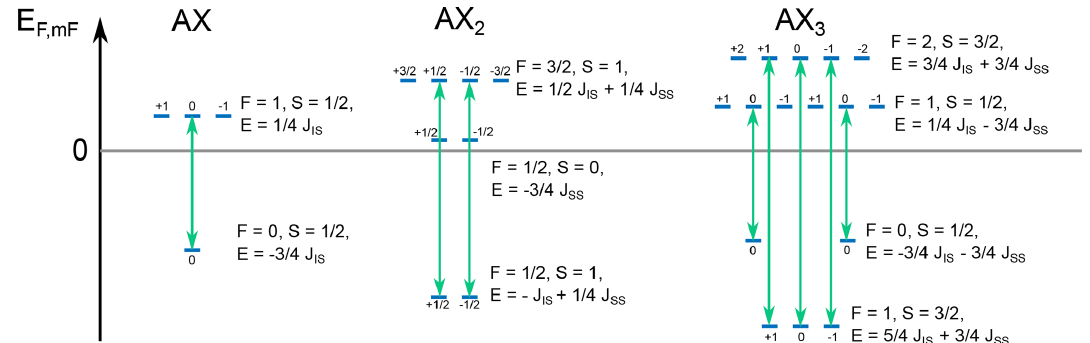
Figure 8. Energy levels for XA, XA 2 , and XA 3 spin systems calculated according to Eq. (54). The numbers above the energy levels represent the z projection of the angular momentum of the states m F . Allowed transitions are shown by green arrows. J AX was set to 140Hz, and J AA was set to − 12Hz; these are typical J coupling values for 1 J CH and 2 J HH . The energy difference for the allowed transitions equals to J AX for the XA system, 3 / 2 J AX for the XA 2 system, and two frequencies of 2 J AX and of J AX for the XA 3 system. This agrees with the numerical simulations shown in Fig.